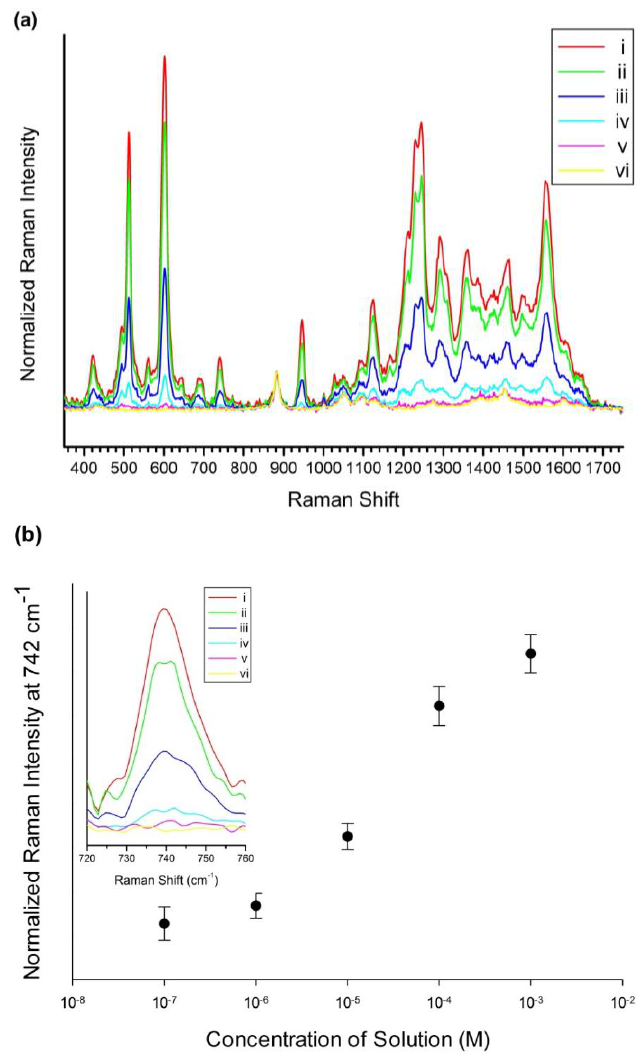
Figure 4. SERS spectra and normalized SERS intensity. ( a ) SERS spectra of SiO 2 @Ag@Et-β-CD NPs mixed with Lut at concentrations from 1 × 10 −3 M to 1 × 10 −7 M; ( b ) Normalized SERS intensities at 742 mixed with Lut at concentrations from 1 × 10 − 3 M to 1 × 10 − 7 M; ( b ) Normalized SERS intensities cm −1 ((i) 10 −3 M, (ii) 10 −4 M, (iii) 10 −5 M, (iv) 10 −6 M, (v) 10 −7 M, and (vi) 0 M). at 742 cm − 1 ((i) 10 − 3 M, (ii) 10 − 4 M, (iii) 10 − 5 M, (iv) 10 − 6 M, (v) 10 − 7 M, and (vi) 0